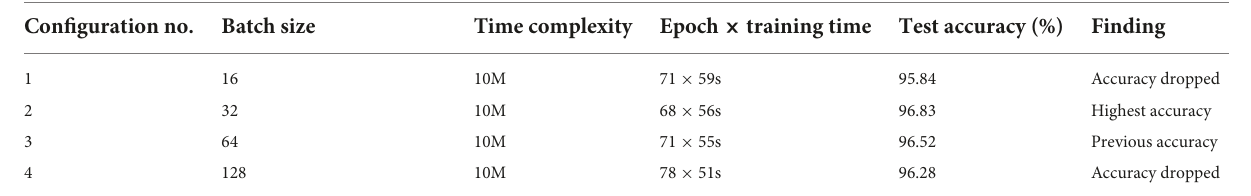
TABLE 4 Ablation study on model hyper-parameters, loss function, and flatten